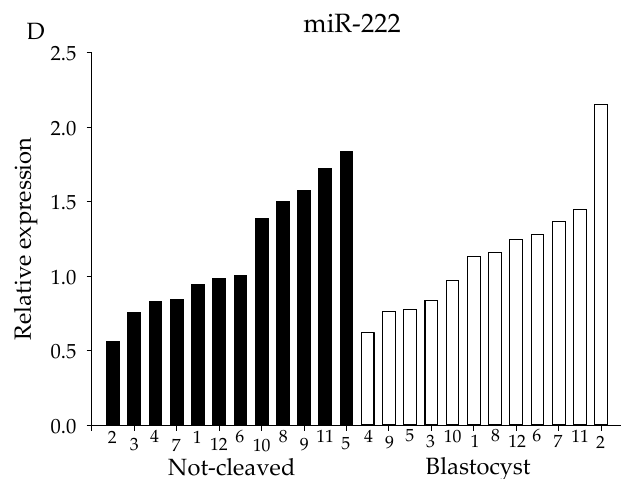
Figure 6. miRNA expression of individual miRNA samples. miRNA expression for cumulus cells from individual COCs. Expression levels of ( A ) let-7g, ( B ) let-7i, ( C ) miR-218 and ( D ) miR-222 as determined by qRT-PCR. X-axes depict individual cumulus complex samples from COCs that had enclosed an oocyte that either failed to cleave (black bars) or developed into a blastocyst (white bars) after exposure to sperm. All samples were normalized for expression of let-7a, miR-26a and miR-191.